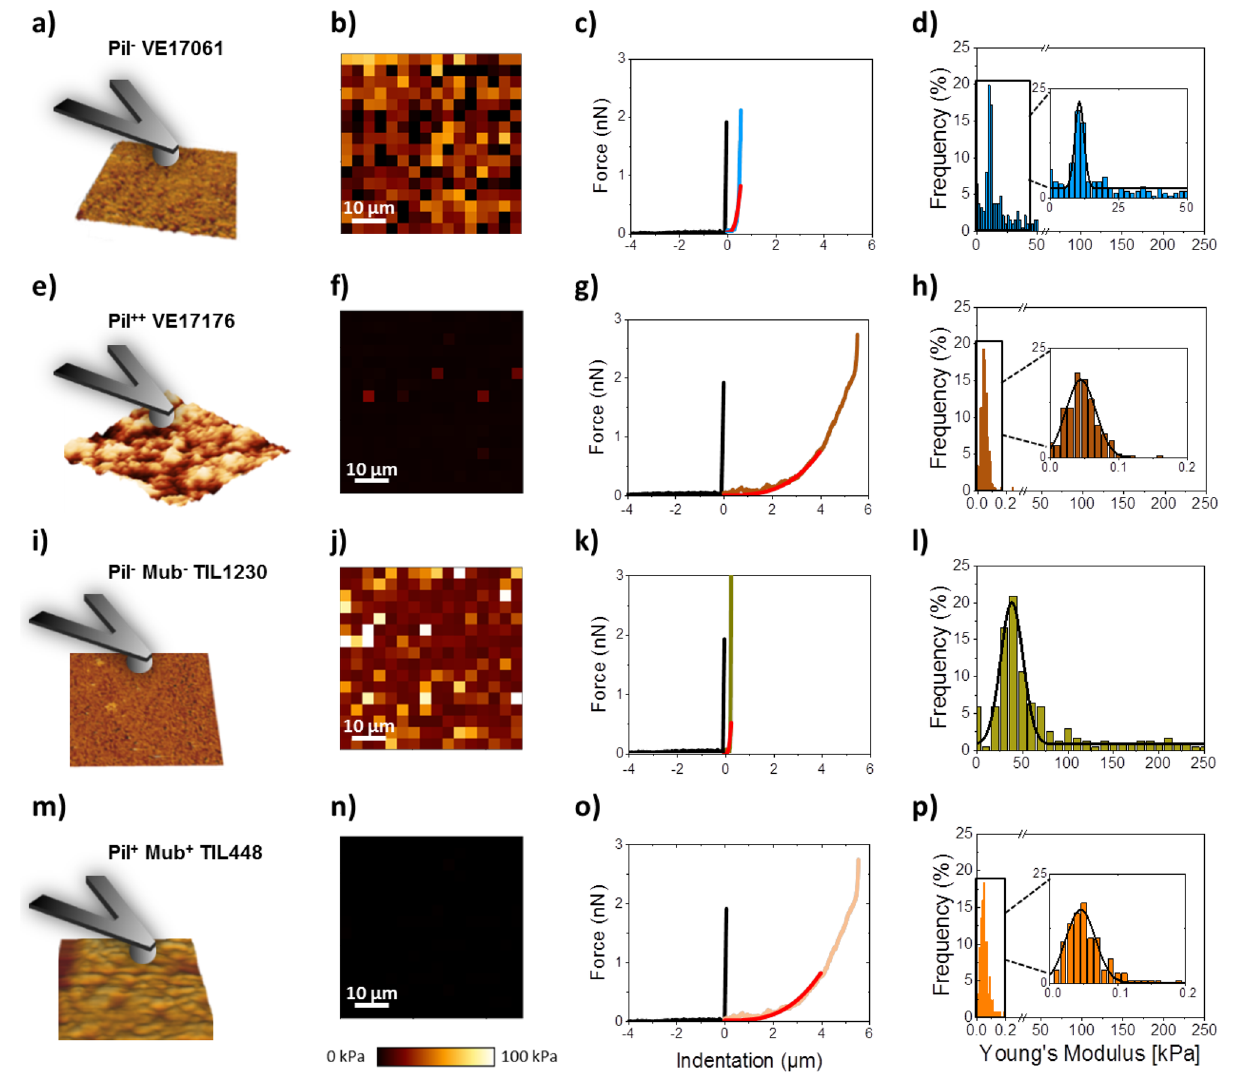
Pil ++ VE17176 (brown line) ( h ), Pil − Mub − TIL1230 (green line) ( l ) and Pil + Mub + TIL448 (orange line) ( p ). All force-curves were recorded for an area of 50 µm × 50 µm corresponding to 16 × 16